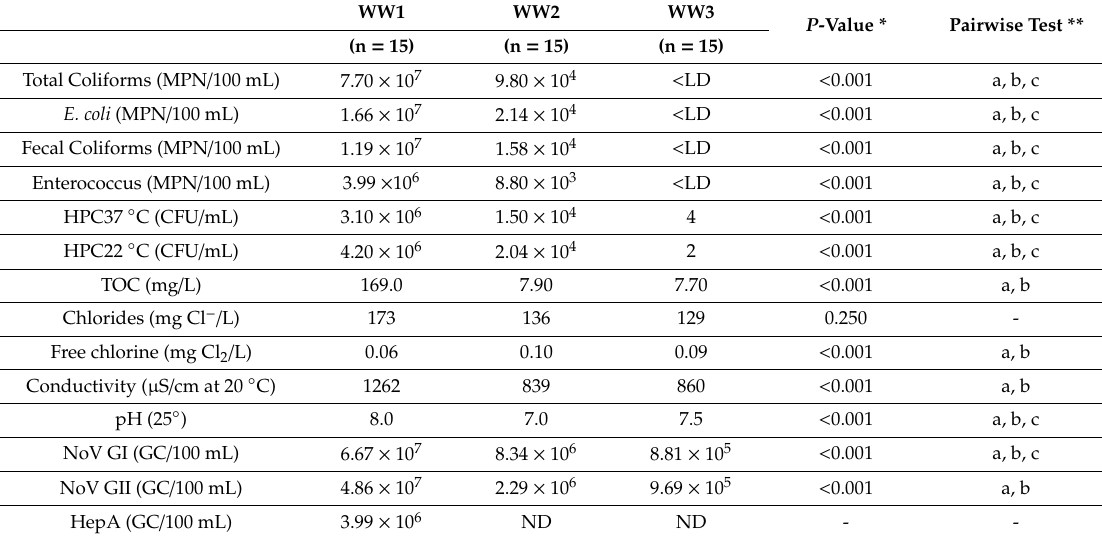
Microbiological, physical, and chemical results (median) for untreated wastewater influent (WW1), e ffl uent with secondary treatment (WW2) and e ffl uent with tertiary treatment